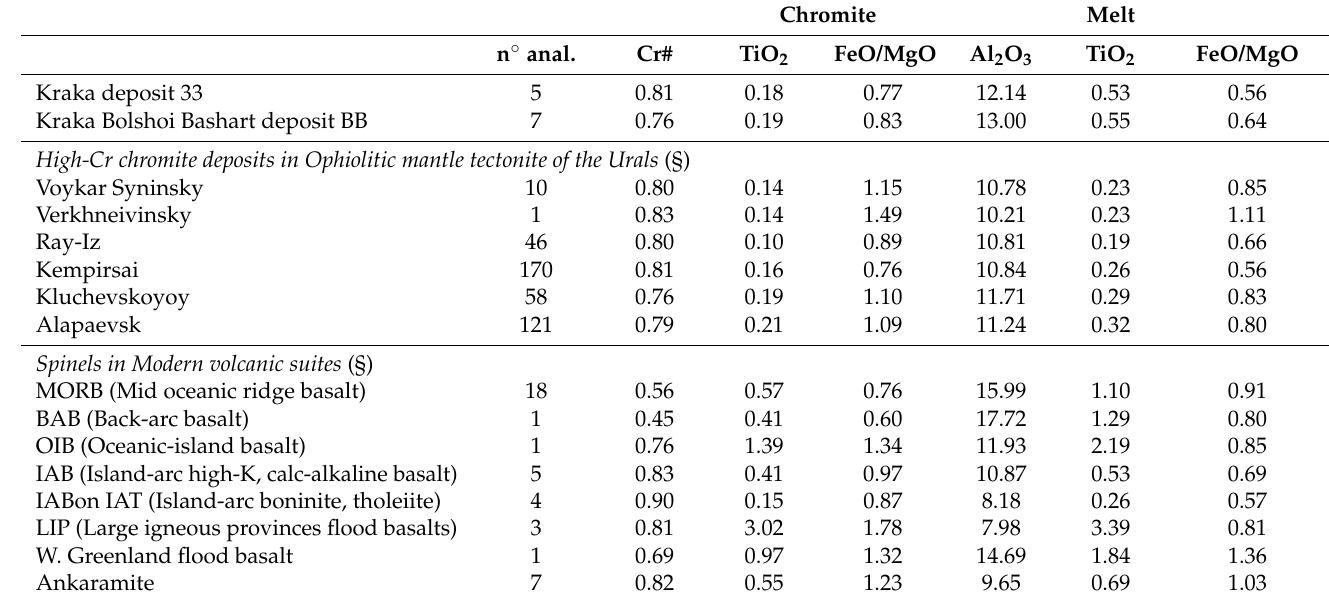
Table 4. Compositions (wt%) of chromites and calculated parental melts for chromitites of the Urals compared with volcanic suites. Chromite Melt n ◦